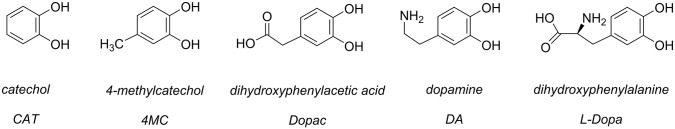
Structures of the diphenolic substrates used for kinetic analysis.